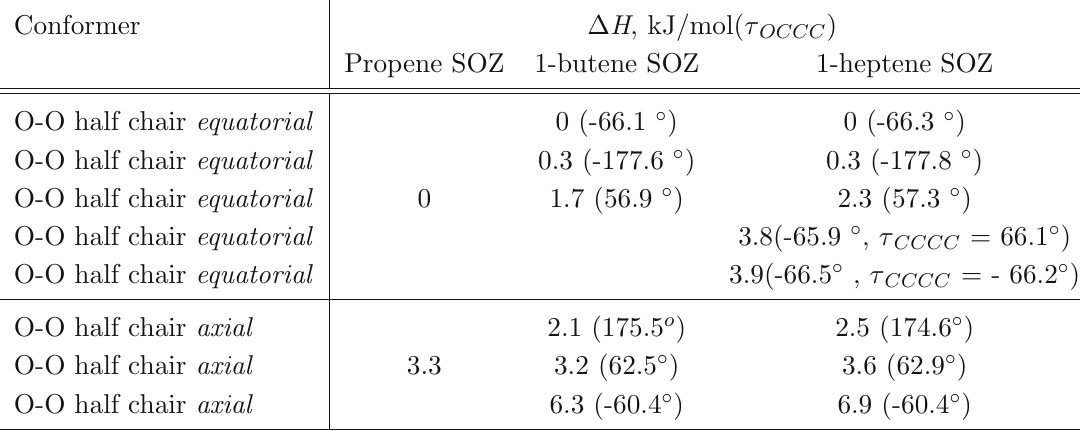
Table 2 DFT calculated (B3LYP \ 6-311++G(3df, 3pd)) relative potential energies (Δ H ) of all staggered conformers of propene, 1-butene and 1-heptene